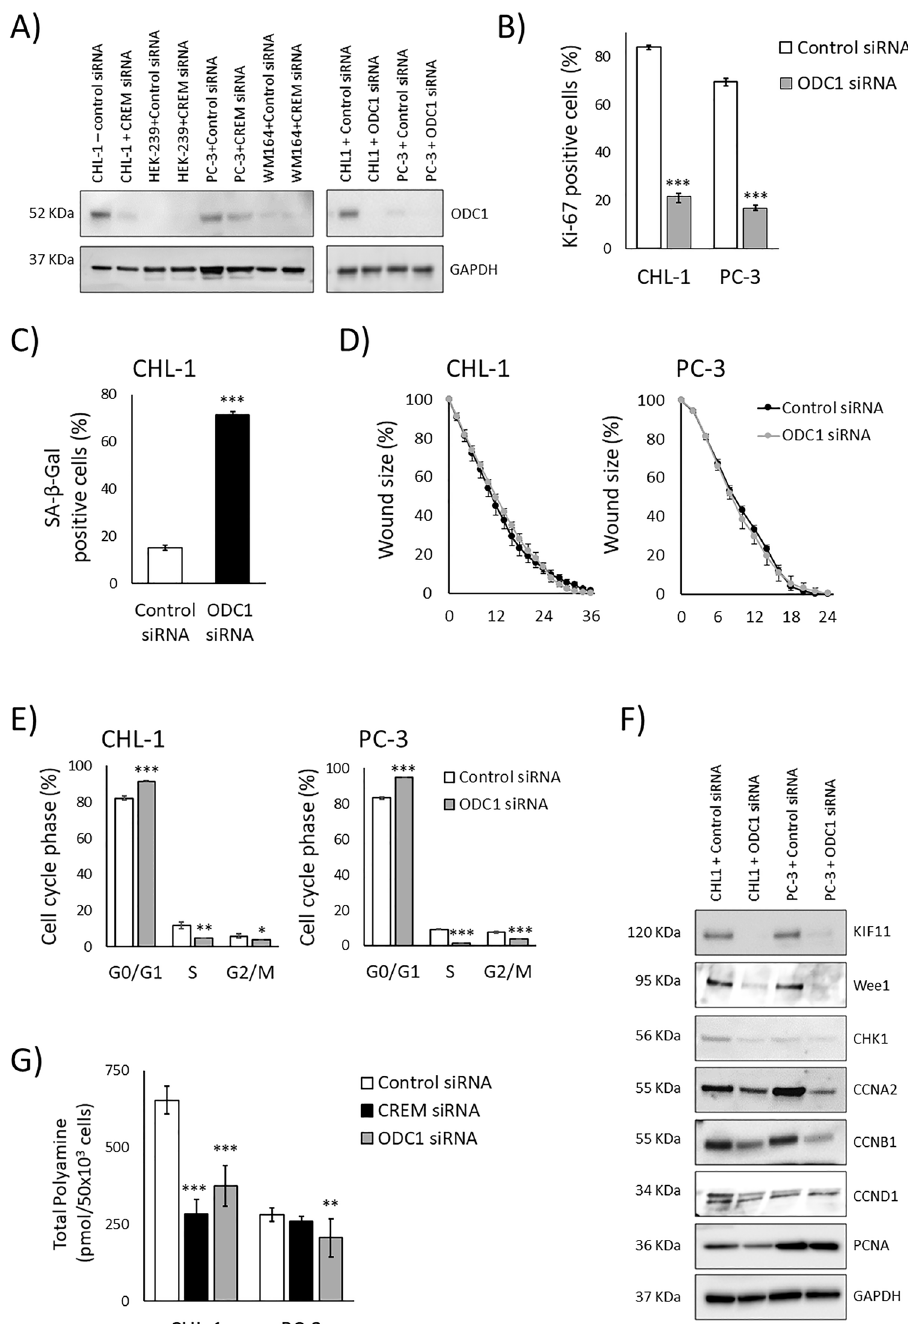
Figure 5. Effects of CREM and ODC1 silencing on cell lines CHL-1 and PC-3. ( A ) Immunoblot showing effects of CREM knockdown and ODC1 knockdown on ODC1 protein levels in in CHL-1, HEK-293, PC3, and WM164 cell lines. The blots are cropped and original blots can be found in Supplementary information— Original blots Supplementary Figs. S9 and S10. ( B ) Proliferation assessed with Ki67 after ODC1 siRNA in CHL-1 and PC3 cell lines. Loss of proliferation was 84–22% in CHL-1 and from 69 to 17% in PC3 cells. ( C ) Senescence assessed with SA β ‐ galactosidase staining after ODC1 knockdown in CHL-1 cell line, an increase from 15 to 71% was seen. ( D ) Wound healing assay to assess migration after ODC1 knockdown in CHL-1 and PC3 cell lines. ( E ) FACS analysis results after ODC1 siRNA treatment for CHL-1 and PC3 cell lines. An increase in G0/G1 in CHL-1cells from 82 to 91% and PC3 in cells from 83 to 95% ( F ) Downstream cell cycle related proteins and their expression measured by immunoblotting after ODC1 knockdown in CHL-1 and PC3 cell lines. The blots are cropped and original blots/replicates can be found in Supplementary information—Original blots Supplementary Figs. S11, S12 and S13. ( G ) Total polyamine concentration compared in CHL-1 and PC3 cell lines after CREM and ODC1 knockdown. * P ≤ 0.05, ** P ≤ 0.01, and *** P ≤ 0.001 ( t